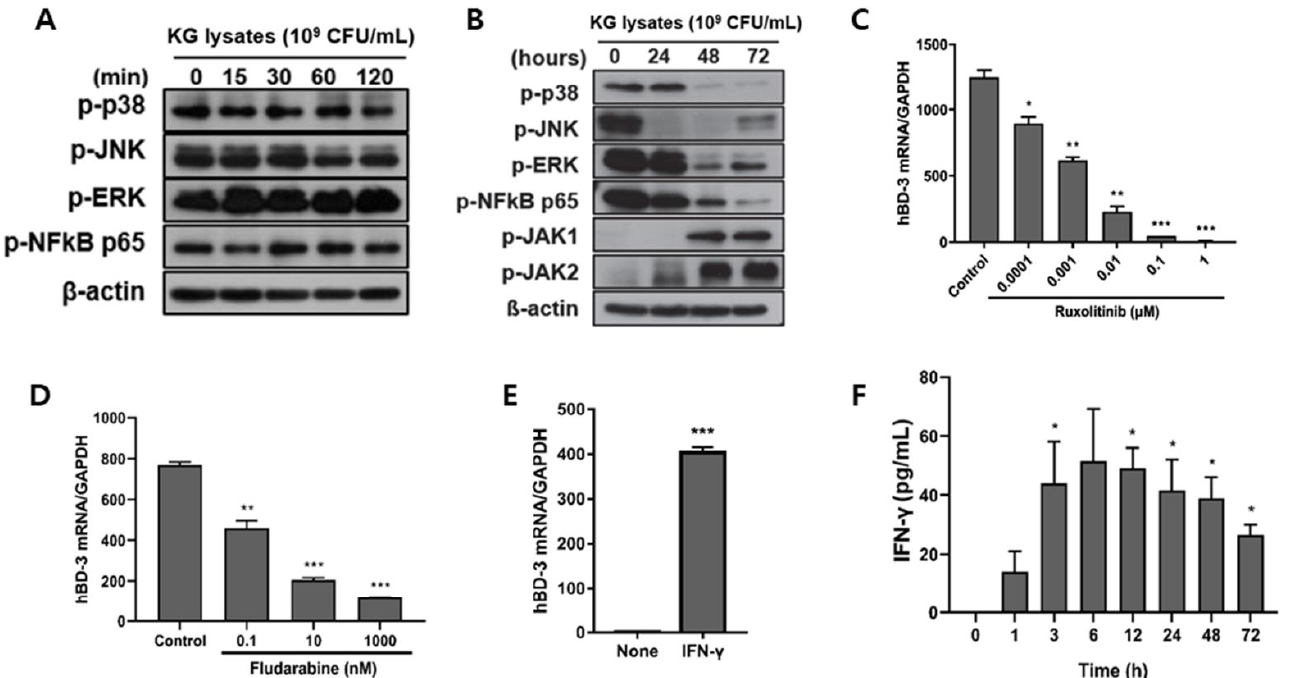
Figure 3. The JAK-STAT1 pathway was involved in KG lysate-mediated hBD3 induction. ( A ) The phosphorylation of signaling molecules were detected by Western blot after HaCaT cells were treated with 1 × 10 9 cells/mL KG lysates for the indicated times. ( B ) HaCaT cells were treated with 1 × 10 9 cells/mL KG lysates for 24, 48, and 72 h and the variation of signaling molecules was examined by Western blot. HaCaT cells were treated with ruxolitinib ( C ) and fludarabine ( D ) prior to KG lysate treatment. hBD3 mRNA level was examined by real-time PCR. ( E ) HaCaT cells were treated with 10 ng/mL recombinant IFN- γ and hBD3 mRNA was examined by real-time PCR. ( F ) HaCaT cells were treated with 1 × 10 9 cells/mL KG lysates and IFN- γ production from culture supernatants was examined by ELISA. *P<0.05, **p<0.01, and ***p<0.001.